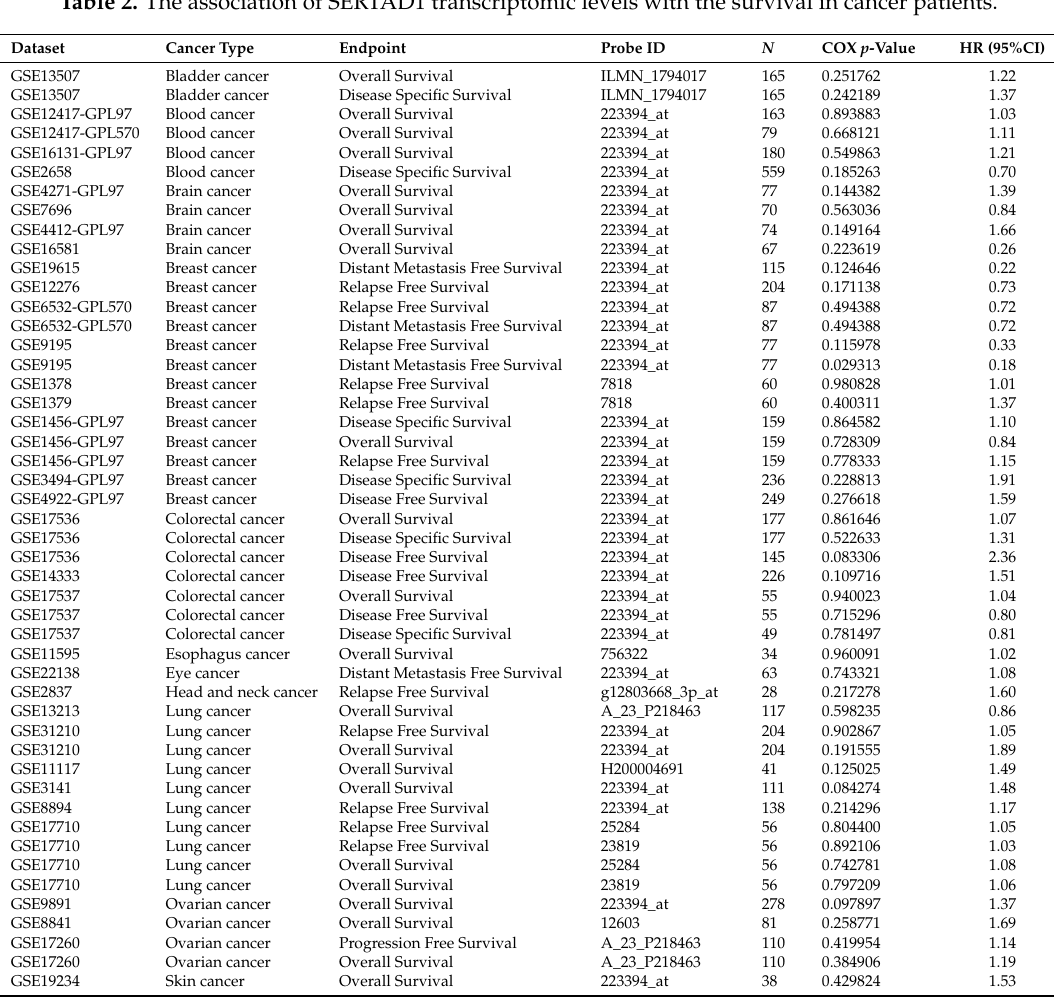
Table 2. The association of SERTAD1 transcriptomic levels with the survival in cancer